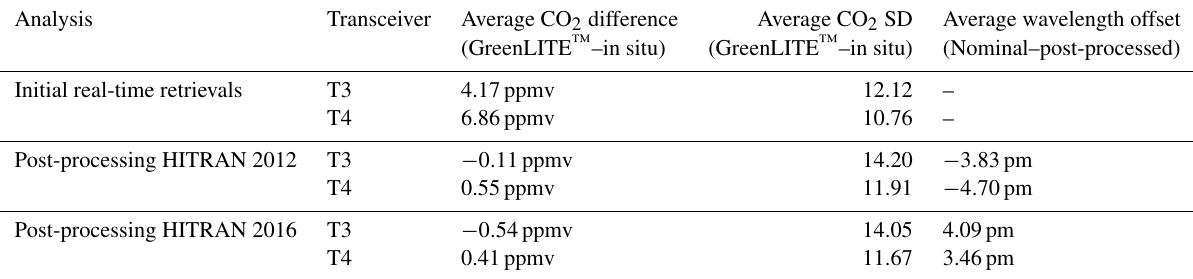
Table 1. Mean bias values for original and post-processed data. These values represent the observed biases over the entire collection period between the GreenLITE ™ observations and average in situ measurements. The average in situ measurements were computed from the collection of all available observations at any instance in time. The average post-processing offsets in wavelengths denote the average difference from measured nominal wavelength settings employed in retrieving the corresponding GreenLITE ™